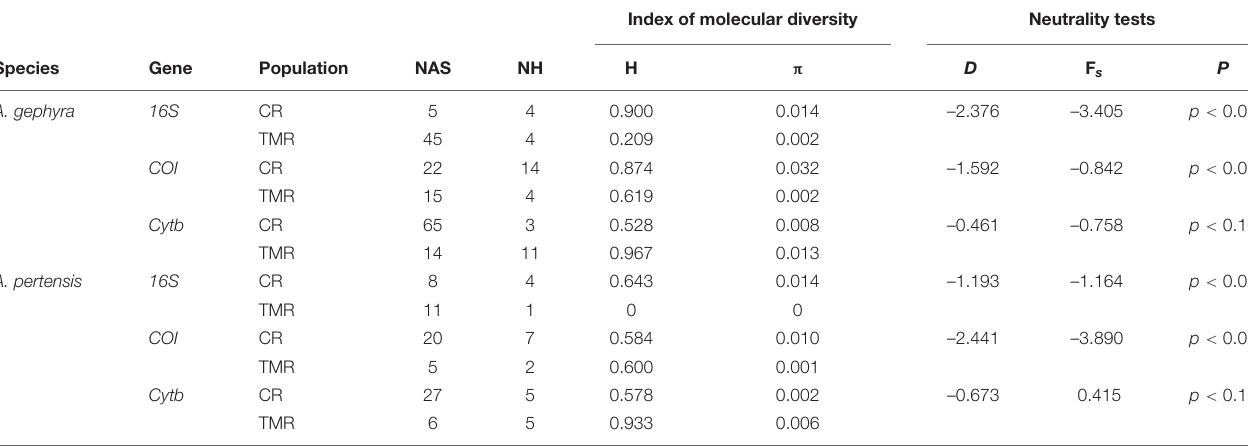
TABLE 4 | DNA Polymorphism and neutrality tests for Apistogramma gephyra and Apistogramma pertensis populations from the Cuieiras River (CR) and Tarumã-Mirim River (TMR).